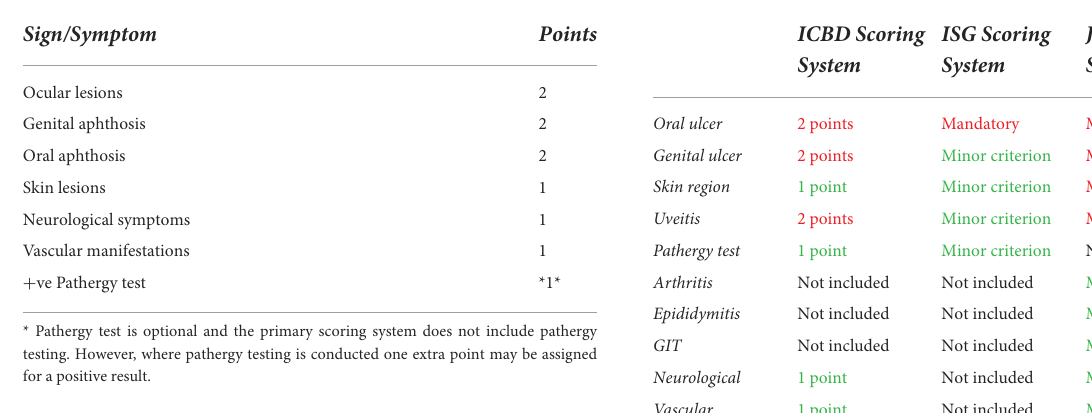
TABLE 2 A comparison between the Japanese, ISG, and ICBD criteria for diagnosis of